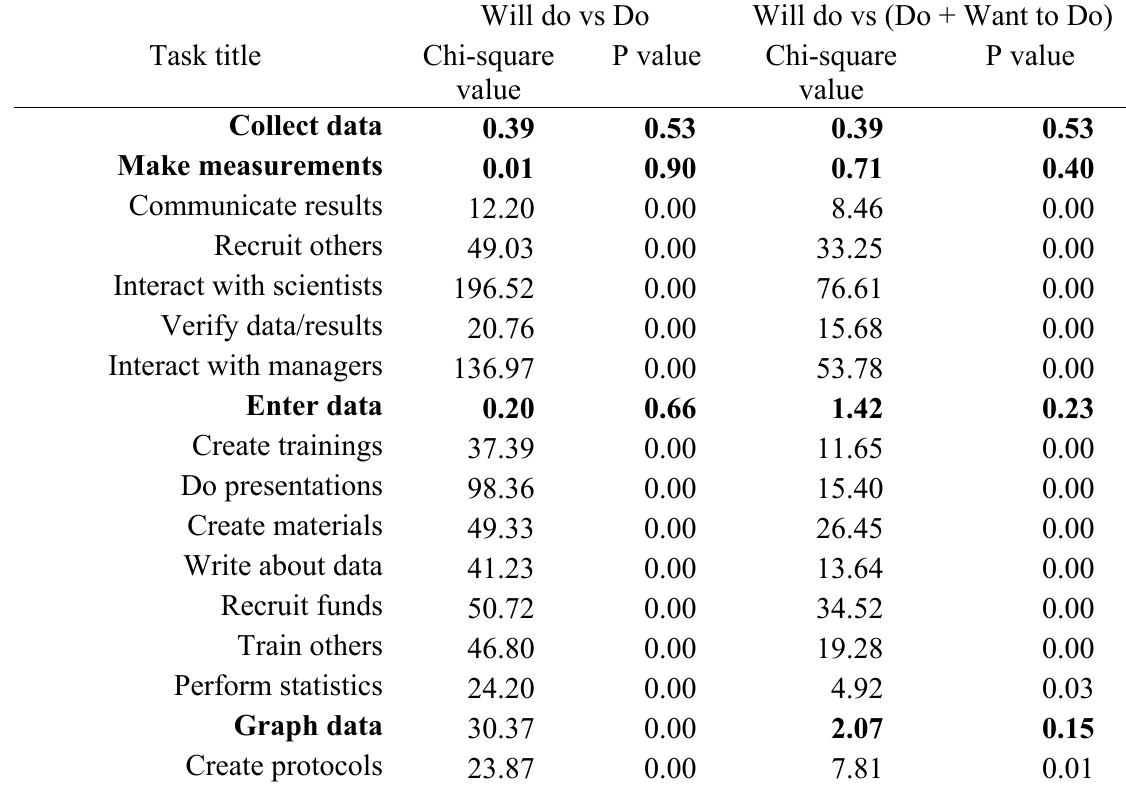
Table A3.2. Results of Chi-square contingency tables comparing new to seasoned participant counts for 17 tasks (see Figure 5). Non-significant comparisons (i.e., new and seasoned participant populations are coincident) are